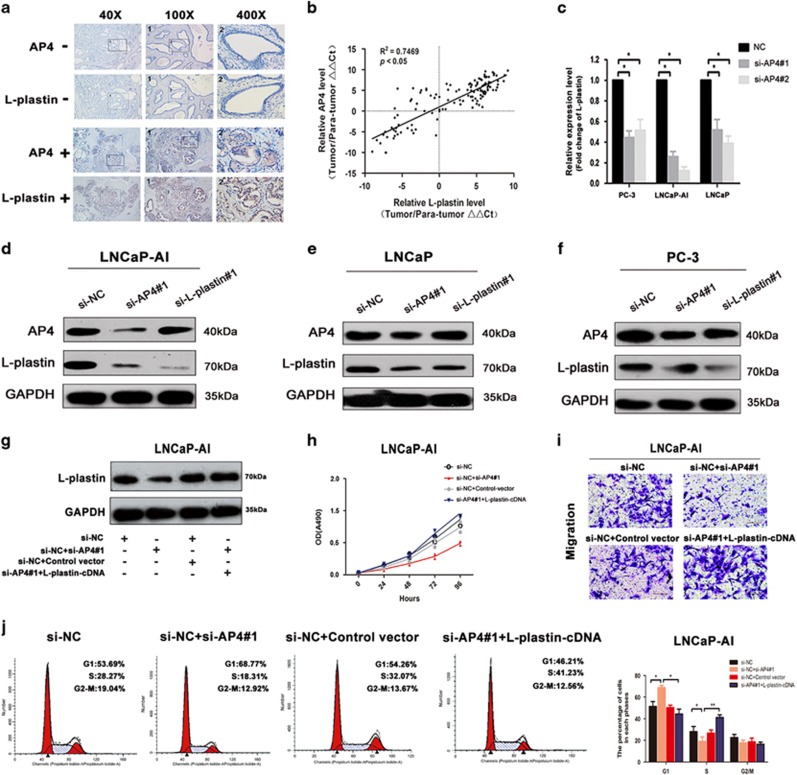
AP4 regulated PCa cells though upregulating L-plastin expression. (a) Representative IHC images of AP4 and L-plastin staining in the human PCa tissues. The micrographs at higher magnification showed weak immunostaining in both AP4 and L-plastin expressions in Case#1, while Case#2 showed strong immunostaining. (b) The association between AP4 and L-plastin mRNA levels in 136 PCa tissues (R2=0.7469, P<0.01). (c) The L-plastin expression after transfection with si-AP4#1 and si-AP4#2 was confirmed by qRT-PCR. (d–f) L-plastin expression was confirmed by western blot analysis after knocking down AP4 transcription using si-AP4#1 and L-plastin transcription using si-L-plastin#1 in LNCaP-AI, LNCaP and PC-3 cells. (g–j) AP4 knockdown was rescued proliferation, migration and invasion of the LNCaP-AI cells by the upregulation of L-plastin in western blotting analysis, MTT assay, transwell assays and cell cycle assays. Values represented the mean±S.D. from three independent experiments. *P<0.05, **P<0.01